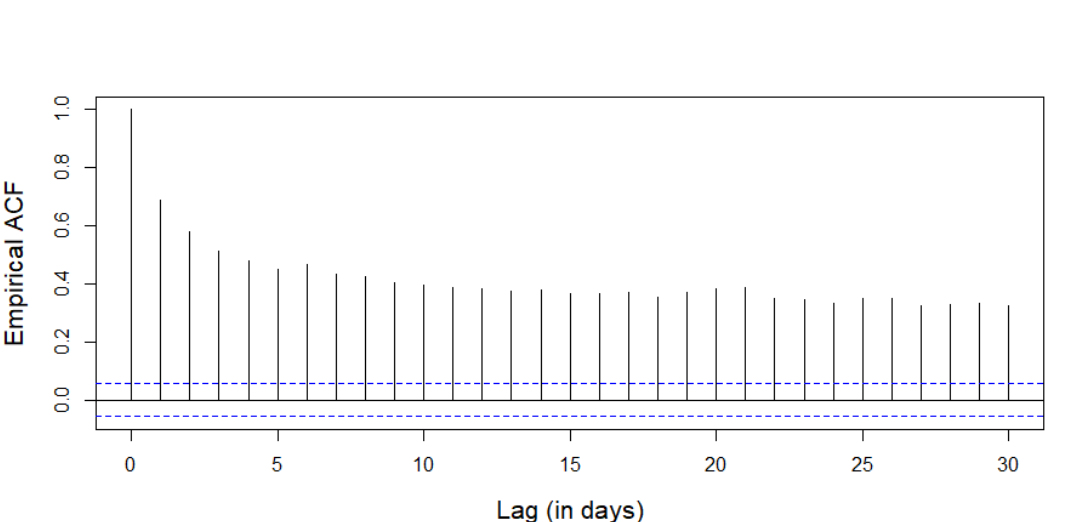
Fig. 3. Empirical autocorrelation function (ACF) for the intraday hourly volatility of Bitcoin returns. Lags are